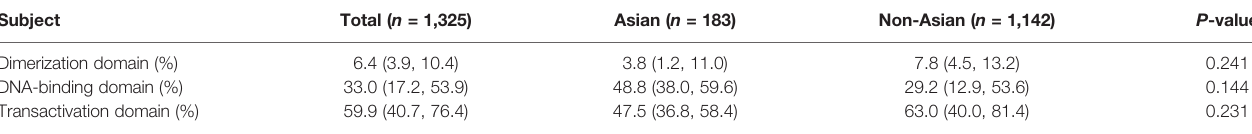
TABLE 3 | Differences in domain mutations between Asian patients and non-Asian patients. Total ( n =